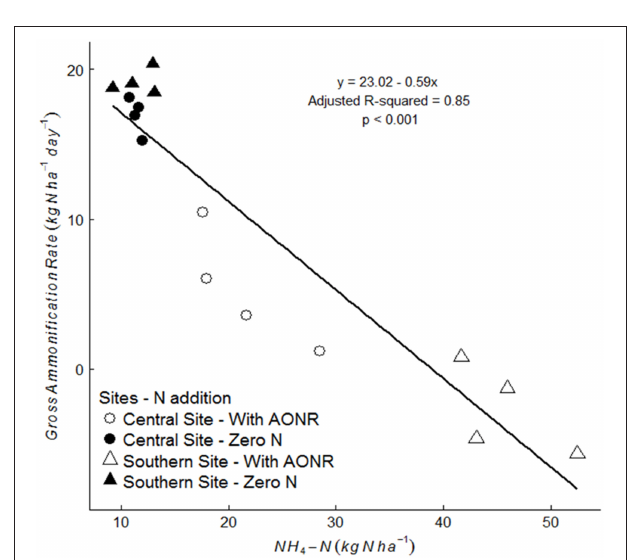
compared to moderate and high historical N rates ( Table 3 ).